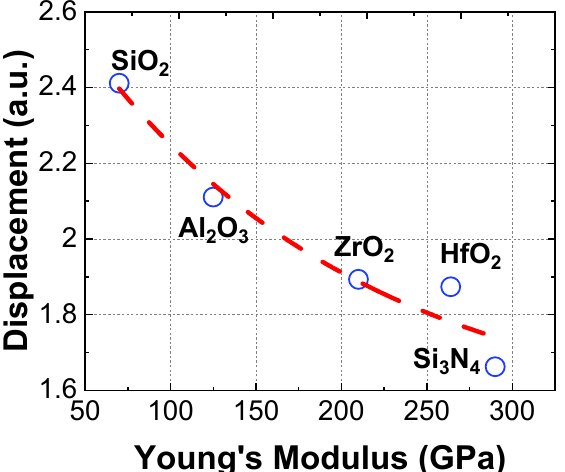
Figure 6. Extracted mechanical displacement with inner space geometry. T INN was fixed at 3 nm.